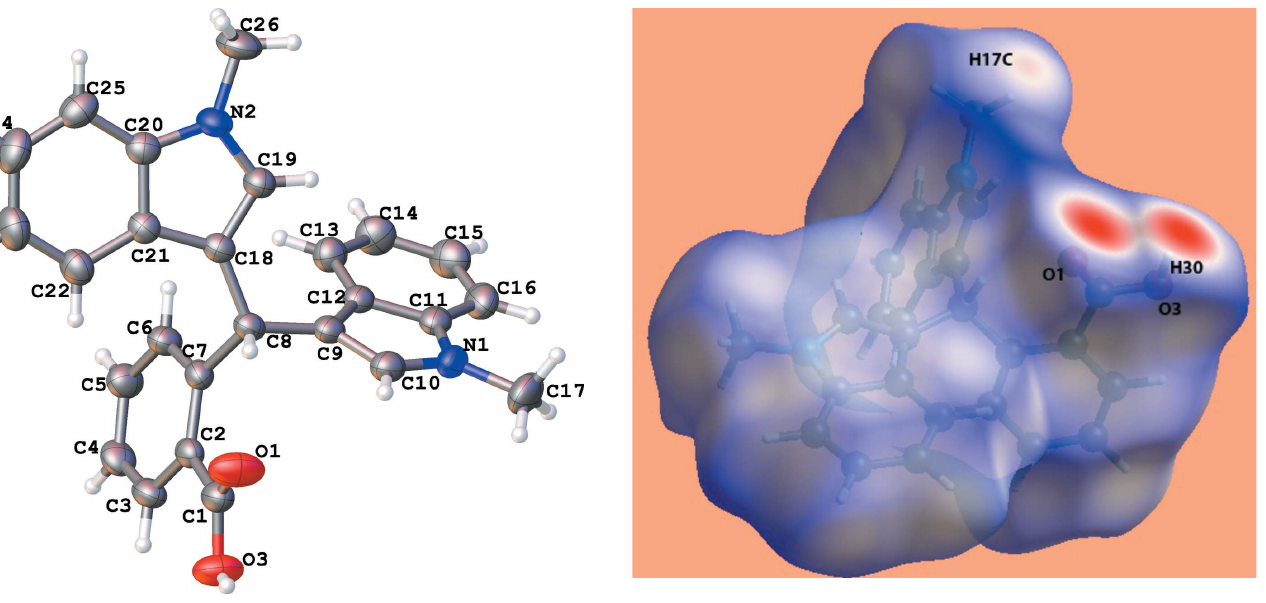
Figure 1 The molecular structure of the title compound with displacement ellipsoids drawn at the 50% probability